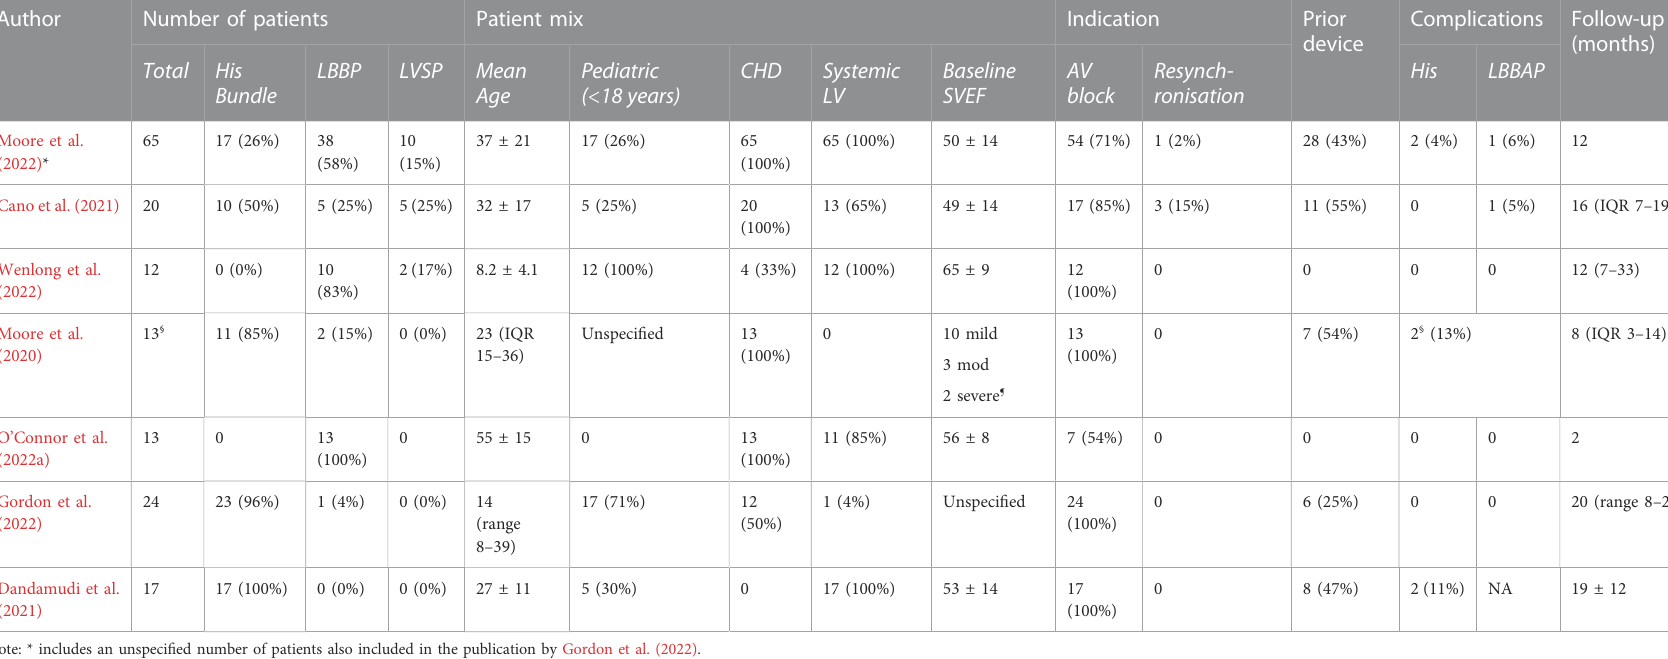
TABLE 1 Summary of Conduction System Pacing (CSP) in publications with ≥ 5 pediatric and/or CHD patients (Kiehl et al.,